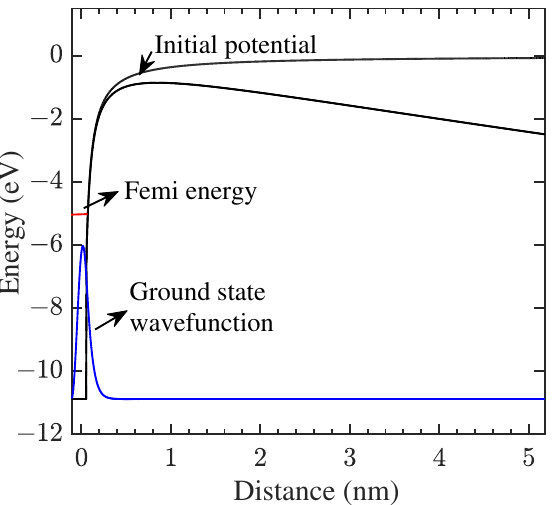
Figure 2. (color online) Model potentials used for both the classical trajectory Monte Carlo (CTMC) and the time-dependent Schrödinger equation (TDSE) simulations. The potential of the electron feels is approximated by a narrow potential well (dashed black curve) with an infinitely high potential wall on the left and a potential step on the right. For the TDSE simulations, the narrow potential contains the ground state electron wavefunction (blue curve) at the Fermi level. Additionally, an image potential is taken into account (see the text for details). The solid black curve represents the suppressed potential when an additional static electric DC field is